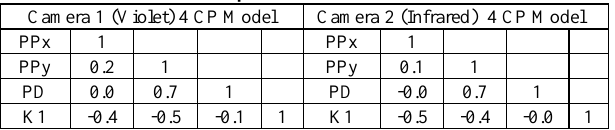
Table 4. Camera calibration parameter correlations for violet and infrared camera networks with 4 calibration parameters per Table 2. Network adjustment results with 4 and 10 CP camera. Correlations are in lower triangular matrix form. calibration models